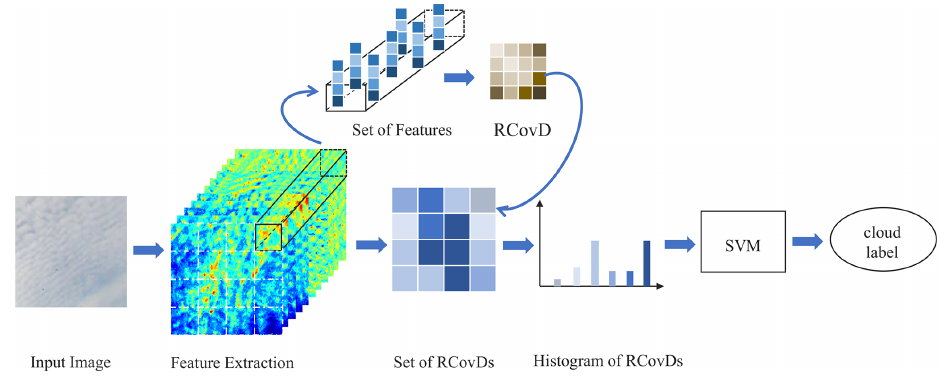
Figure 1. Pipeline of the proposed cloud classification method. Multiple pixel-level features are firstly extracted from the cloud image blocks to form RCovDs; then the histogram representation of RCovDs is obtained by Riemannian BoF; finally, the cloud type is predicted by multiclass SVM.